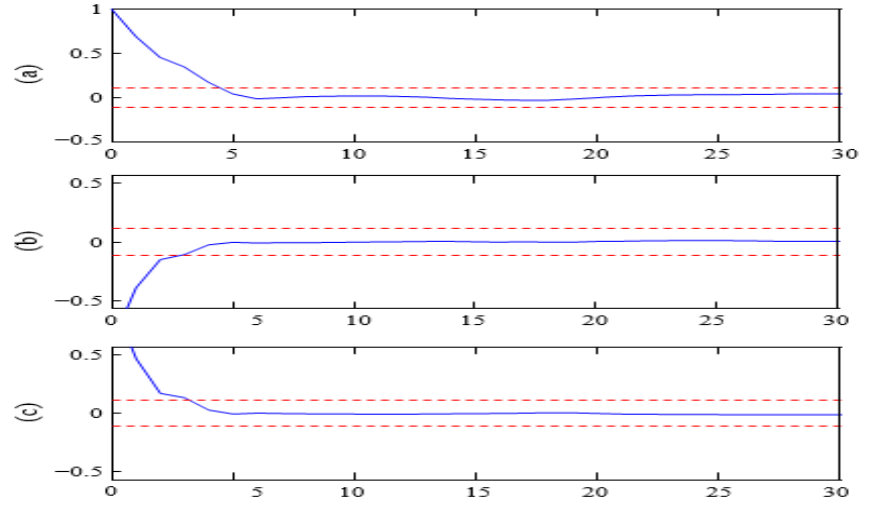
Figure 9. Model validation results of the proposed method: ( a ) φ ε (cid:48) ε (cid:48) ( τ ) ; ( b ) φ ε (cid:48) ( ε 2 ) (cid:48) ( τ ) ; ( c ) φ ( ε 2 ) (cid:48) ( ε 2 ) (cid:48) ( τ ) .